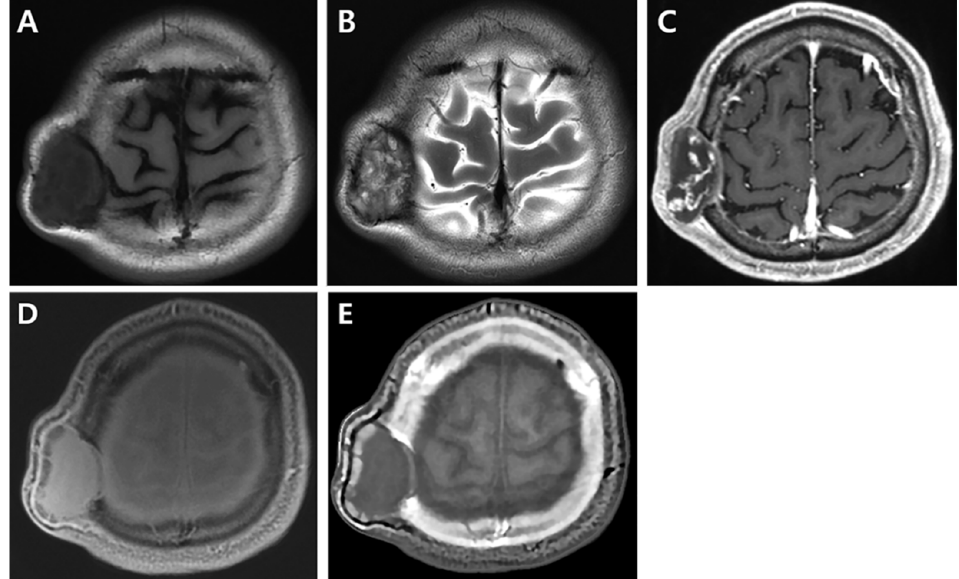
Figure 2. Computed tomography of the brain. ( A ) Soft tissue window setting. The lesion shows inhomogeneous attenuation with marginal capsule and multifocal bone tissues along the outer margin (arrows). ( B ) Contrast enhanced axial image showing multifocal septa-like enhancing components within the lesion. ( C ) Bone window settings. A well-circumscribed, oval, osteolytic lesion is noted in the right parietal bone with multifocal bone tissues in the outer margin, representing the remainder of the outer table (arrows).